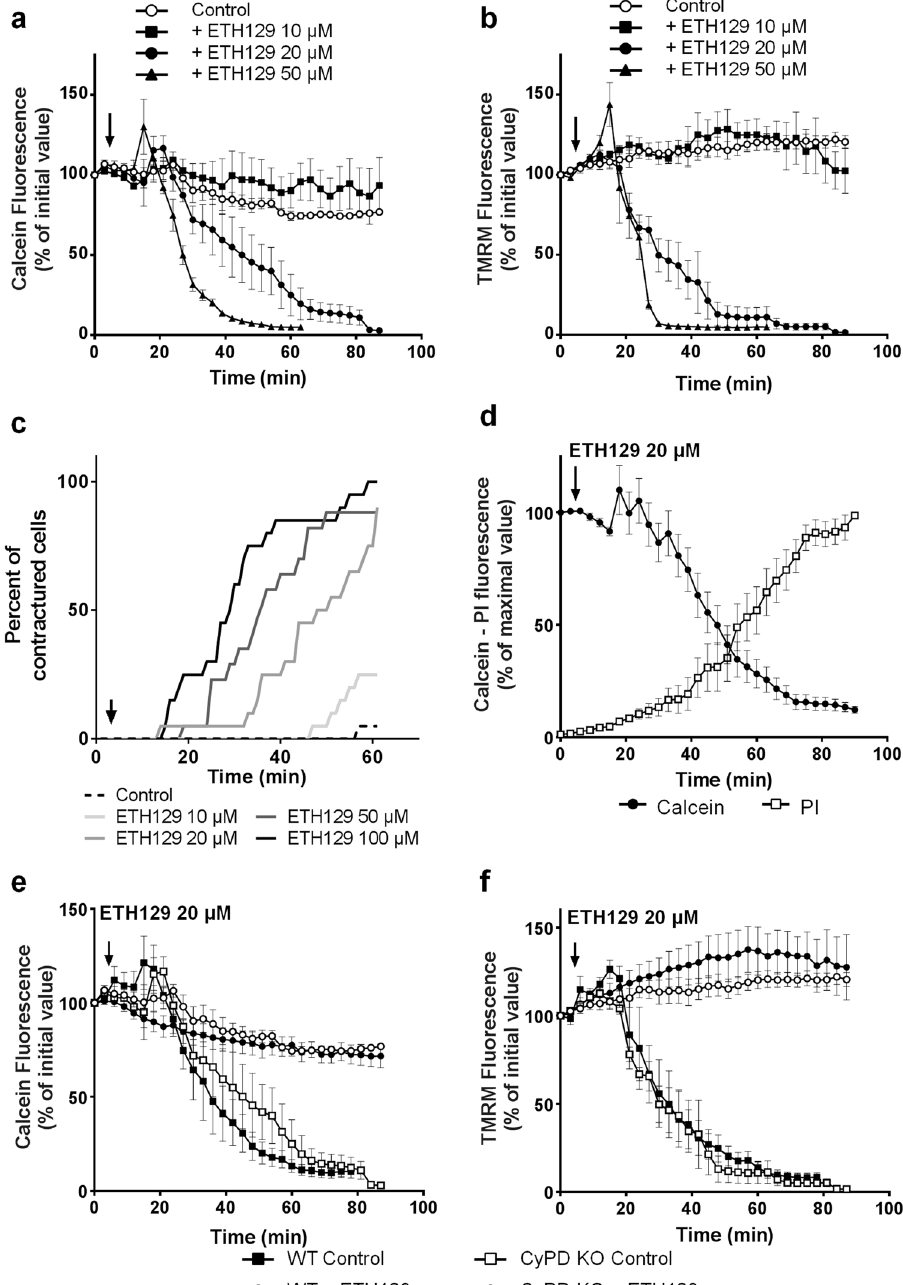
Figure 4. Effects of ETH129 on isolated mouse cardiomyocytes. ( a and b ) Isolated mouse adult cardiomyocytes were co-loaded with calcein, CoCl 2 and TMRM at 37 °C and then incubated in a Tyrode’s buffer. After 5 min incubation ETH129 (arrow) was added to the medium. ( c ) ETH129 induces a concentration-dependent hypercontracture of cardiomyocytes. ( d ) Isolated mouse adult cardiomyocytes were co-loaded with calcein, CoCl 2 and propidium iodide (PI) at 37 °C and then incubated in a Tyrode’s buffer. After 5 min incubation ETH129 (20 µ M; arrow) was added to the medium. ( e and f ) Cardiomyocytes isolated from wild type (WT) or CypD knock out (KO) mice were co-loaded with calcein, CoCl 2 and TMRM at 37 °C and then incubated in Tyrode’s buffer. After 5 min incubation, 20 µ M ETH129 (arrow) was added to the medium. Fluorescence values were obtained by averaging pixel intensities after background substraction and were normalised as a percentage of the initial value. Each trace represents the mean ± SEM of 3–5